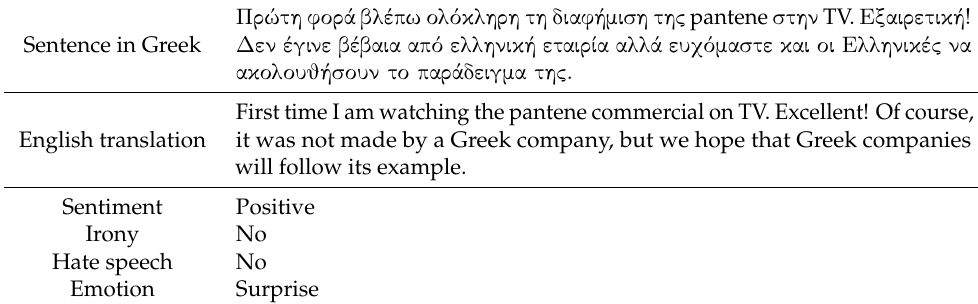
Table 4. Example sentences in Greek, translated to English, with the true labels.